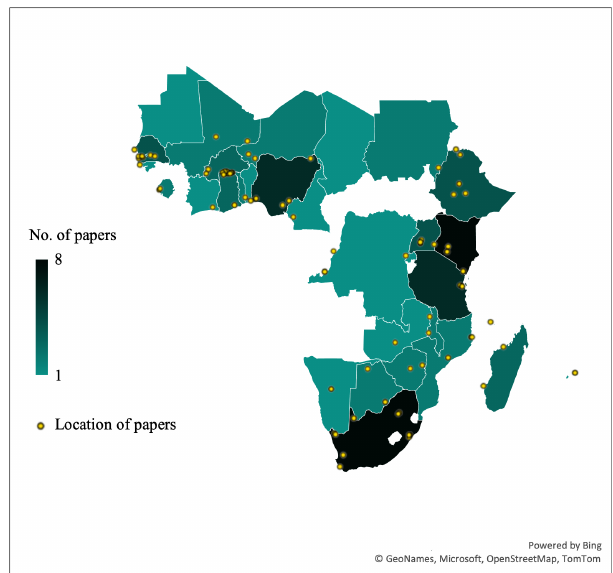
Figure 2. Locations of papers on NBSs for hydro-meteorological risk mitigation in SSA.